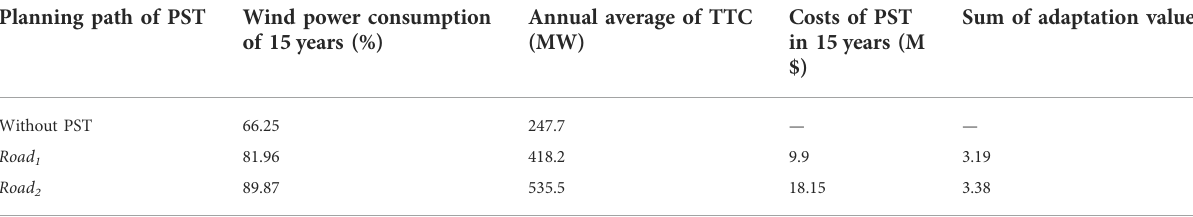
TABLE 3 IEEE 118-bus system results of Road 1 and Road 2 . Planning path of